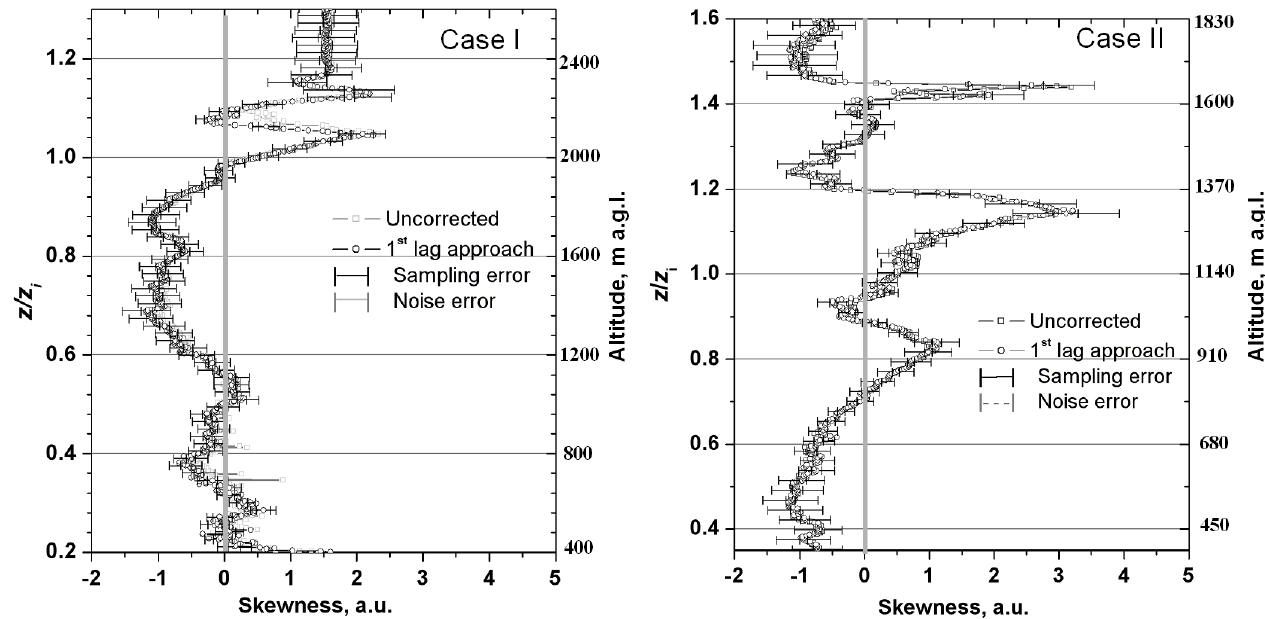
Fig. 13. Same as Fig. 11 but for skewness S k for Case I (left) and Case II (right). For a Gaussian distribution, S k is 0 (gray